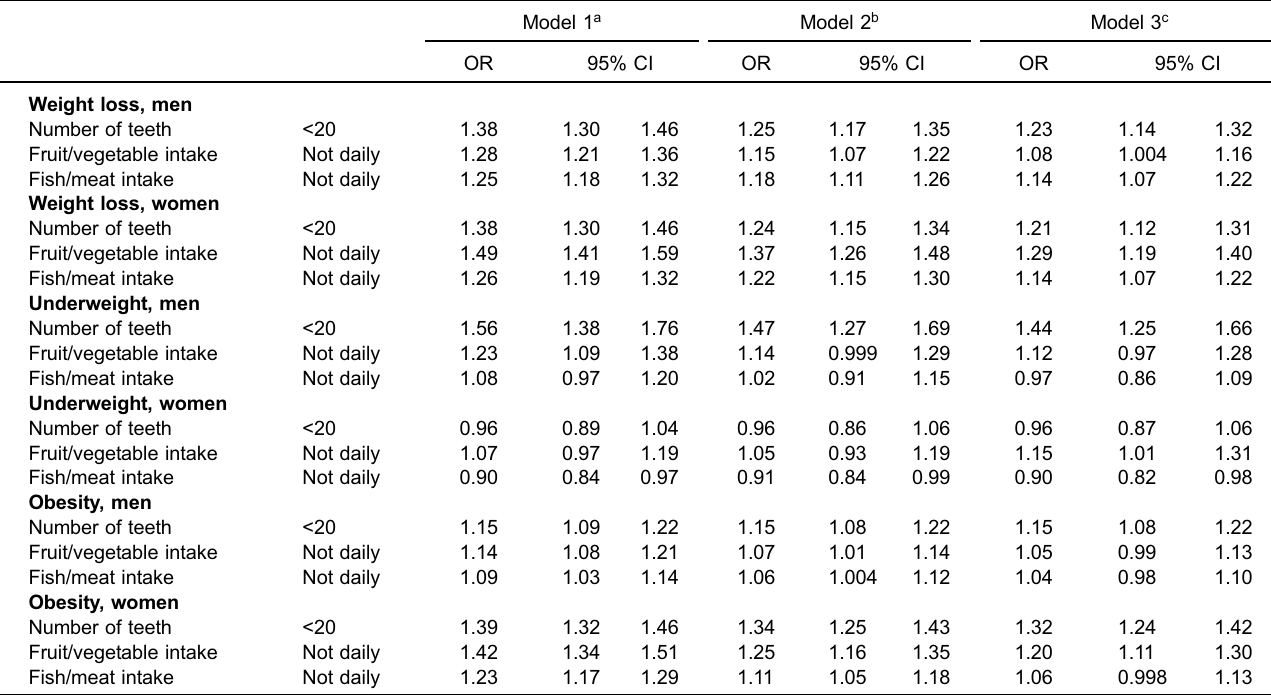
Table 2. Odds ratios for weight loss, underweight, and obesity according to number of teeth and frequency of food